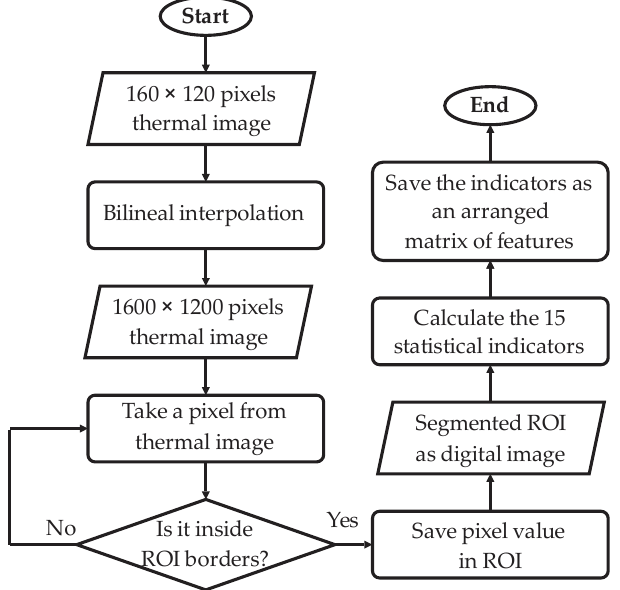
Figure 6. Flow diagram of the image processing module implementation.